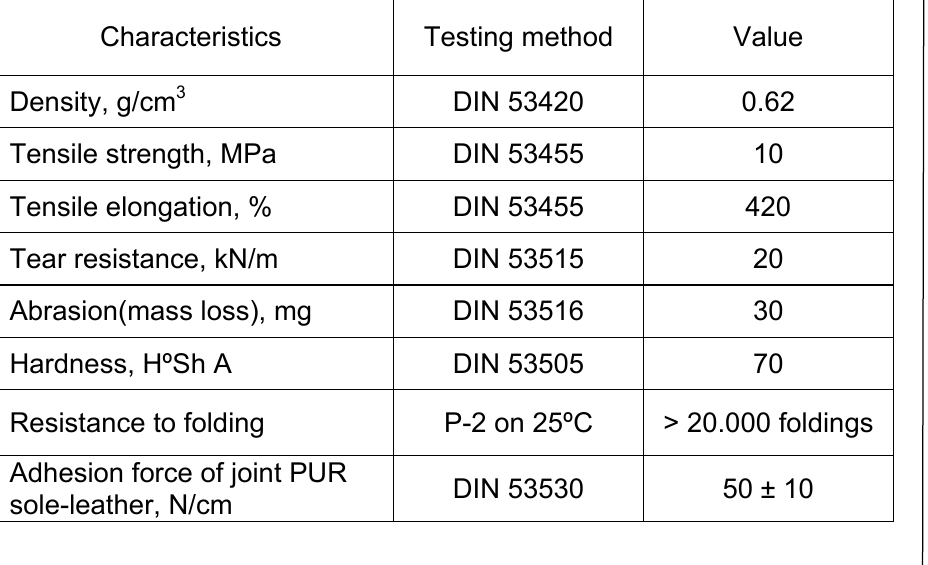
Table 1 – Characteristics of the polyurethane material for LIM technology Таблица 1 – Характеристики полиуретанового материала для технологии